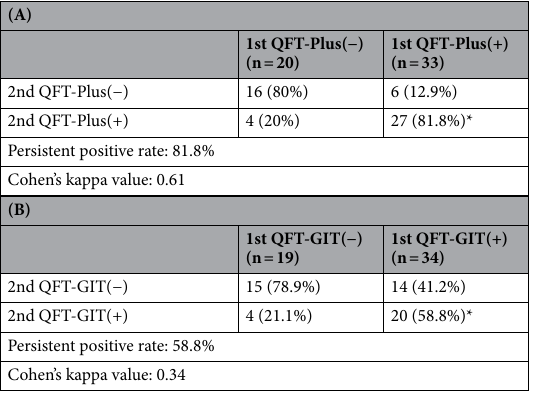
Table 3. The intra-test discordance and concordance of serial QuantiFERON-TB Gold Plus (QFT-Plus) and QuantiFERON-TB Gold In-tube (QFT-GIT) tests, respectively. *p = 0.040 by comparing persistent positivity between the 1st and 2nd QFT-GIT(+) versus the 1st and 2nd QFT-Plus(+) using Pearson chi-squared test.